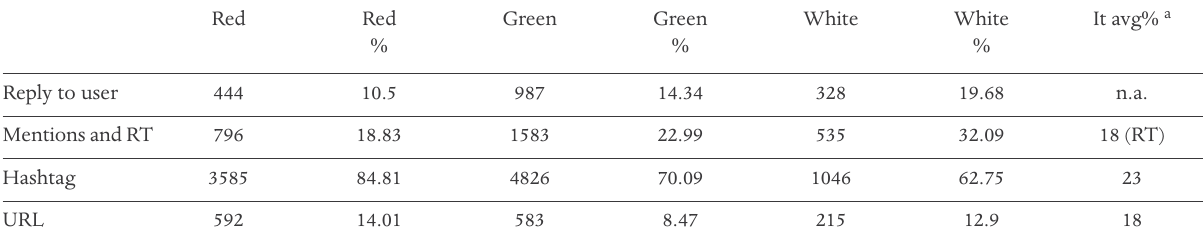
Table 4. Types of tweets tweeted in the 3 zones. ( a ) Italian average, source (Spring 2012):